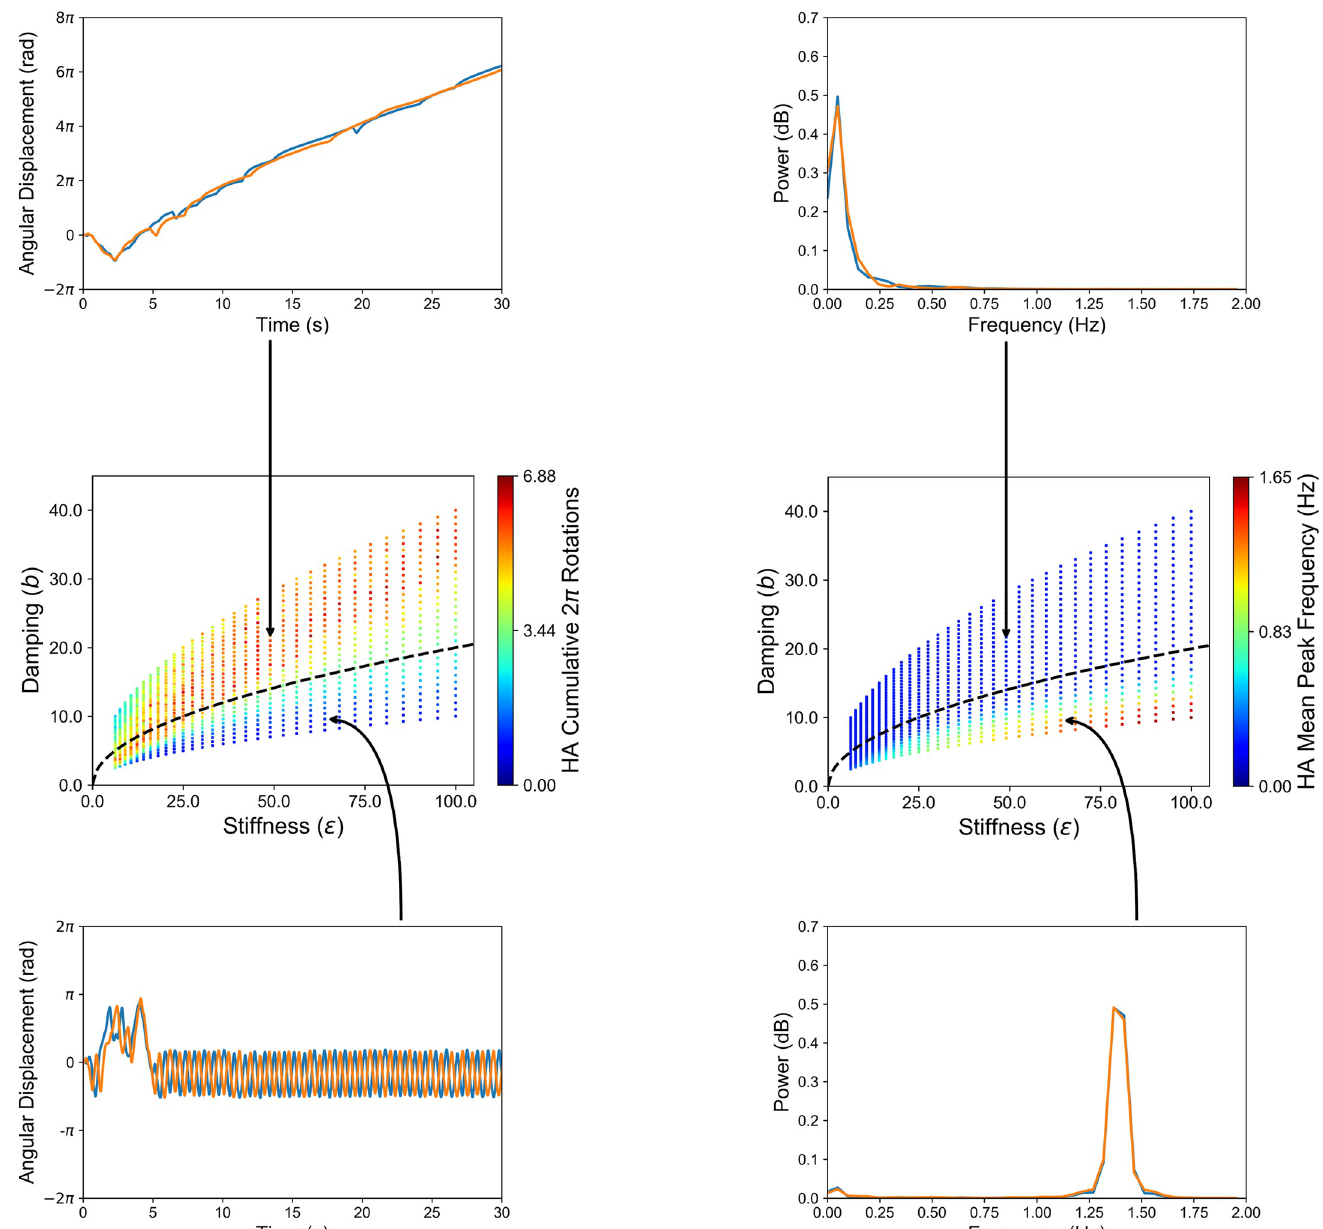
Fig 5. Two different emergent behaviors as a function of changes to stiffness and damping (middle row), as illustrated by the cumulative 2π rotations (middle left) and the mean peak frequency of angular movement (middle right) by artificial herding agents (HAs). The black dashed line represents critical damping ( z = ffiffiffiffiffiffiffi p 1), which satisfies the condition b ¼ 2 ( m = 1 kg). Parameters above the line indicate overdamping ( z > 1), while those below indicate underdamping ( z < 1). m ε Artificial HAs embodying the task-dynamic model defined in Eqs 1–3 exhibited circling movements around the target agent (TA) herd when the model was overdamped (top left). When the model was underdamped, the two artificial HAs exhibited oscillatory behavior (bottom left) at a peak frequency consistent with previous work studying human collaborative problem-solving (bottom-right power spectrum) [11, 17]. Angular displacements in the negative/positive direction indicate counterclockwise/clockwise motion. See also S4 and S5 Videos .